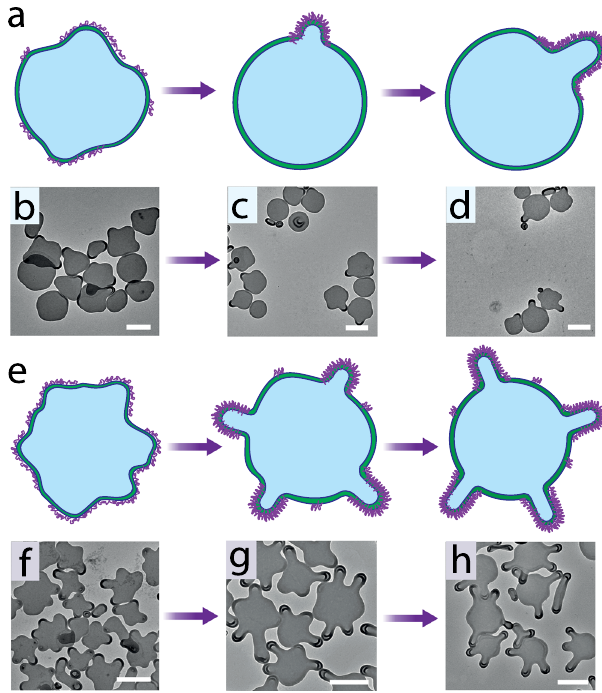
Fig. 5 The segregation of PNIPAm in polymersome